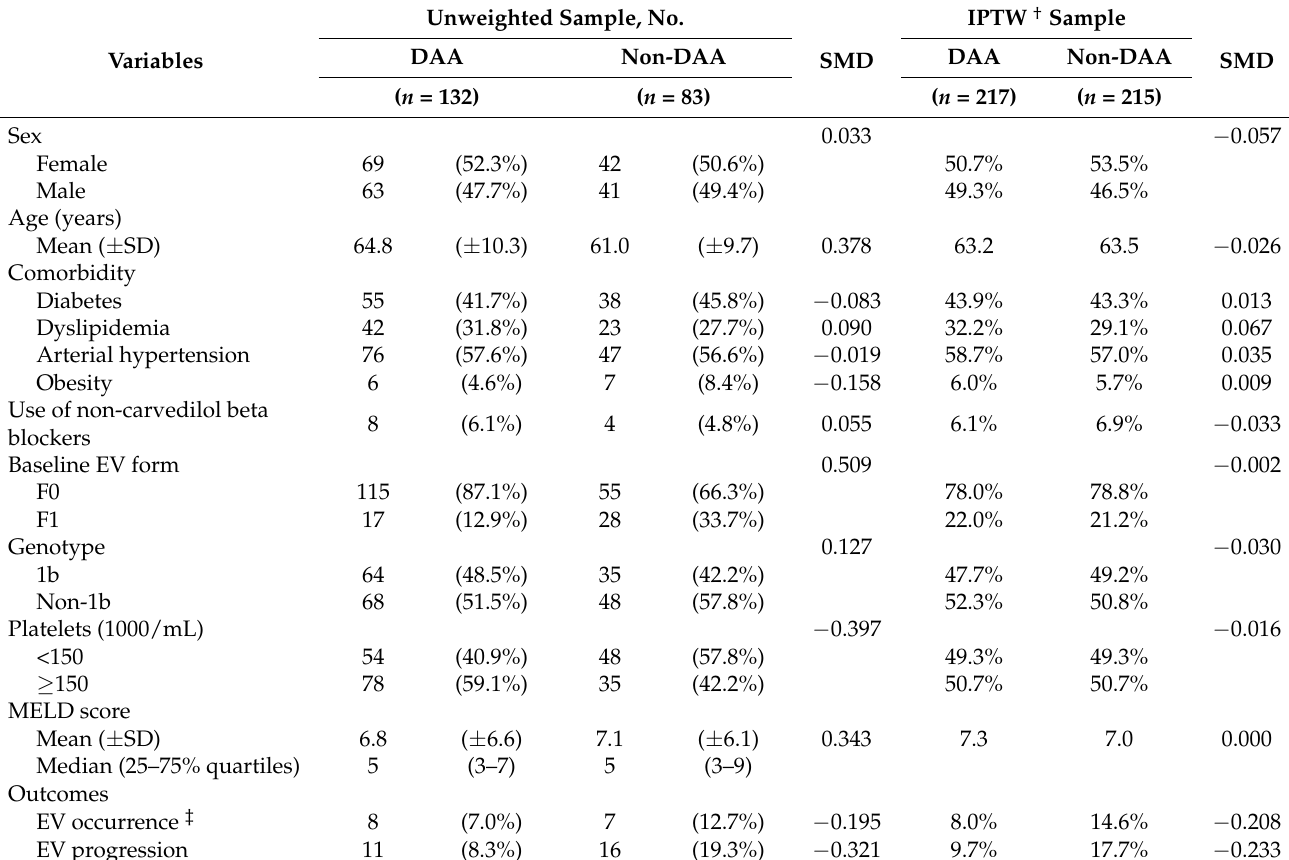
Table 1. Baseline characteristics of